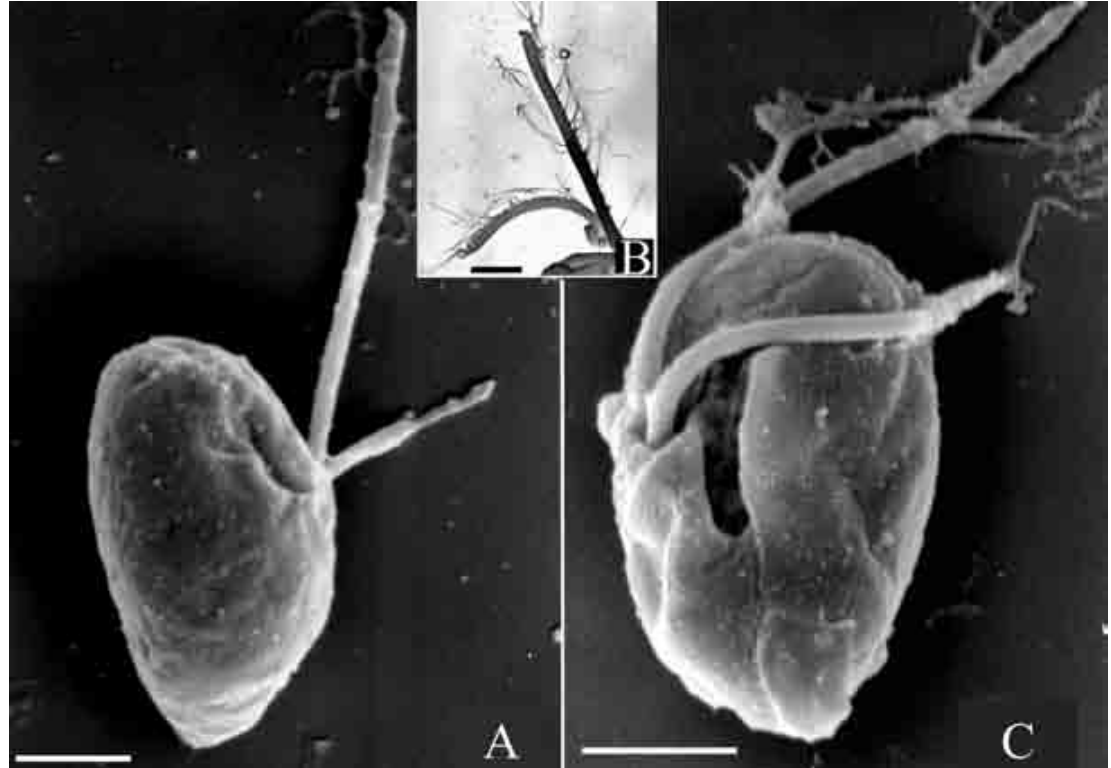
IG . 5. – Hemiselmis sp. inedit. from the Mediterranean Sea, SEM, HMDS-dried material. A , a cell in lateral view. B , arrangement of fla- gellar mastigonemes (reverse print). C, this cell in ventral view shows the characteristic ventral furrow, which is displaced towards the left-hand side of the point of flagellar insertion. Scale bars = 1